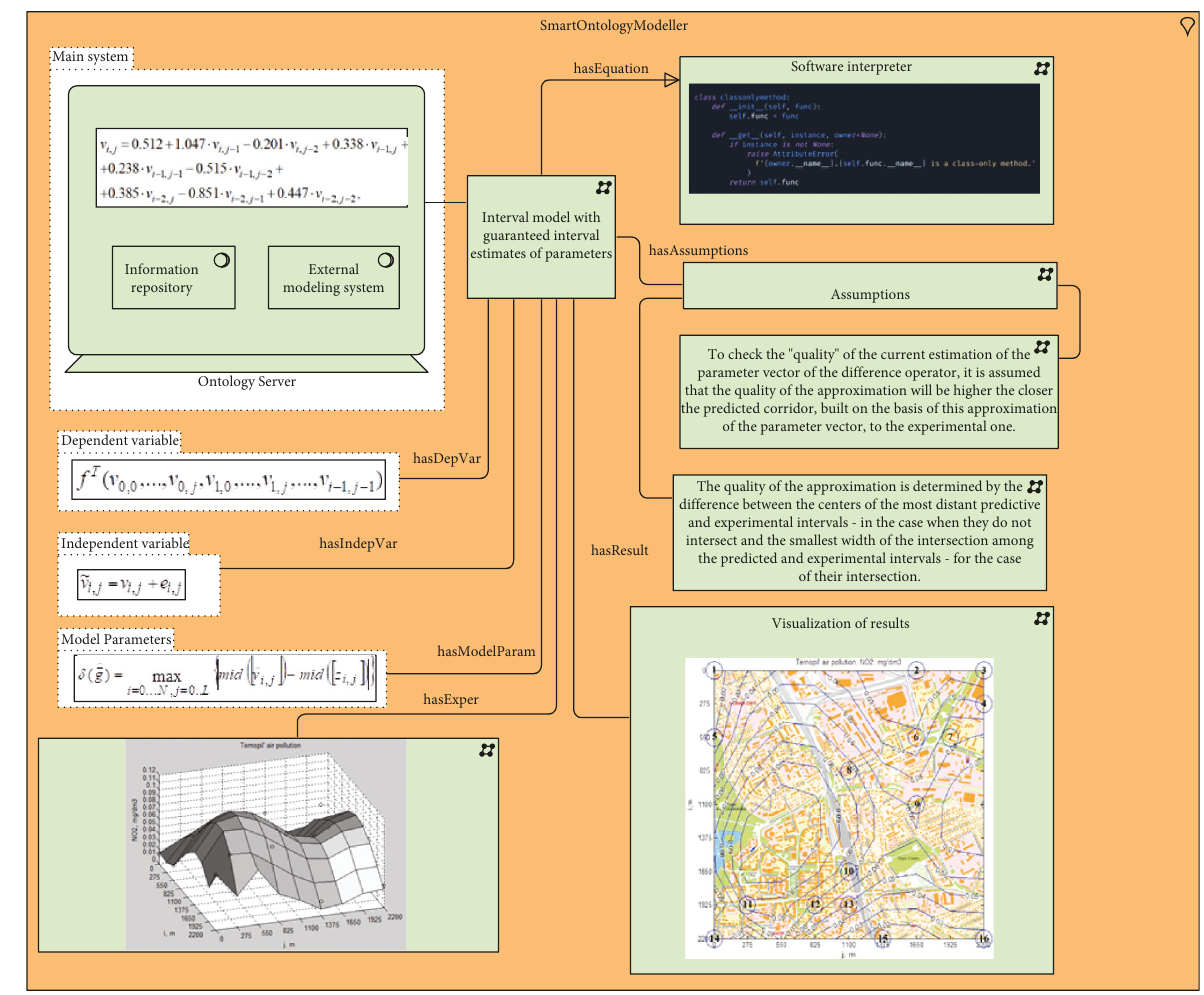
Figure 4: An example of implementing the ontology of the interval model for simulating the fields of harmful emission concentrations in the squat layer of the atmosphere in the conditions of large errors of observations in the SmartOntologyModeller